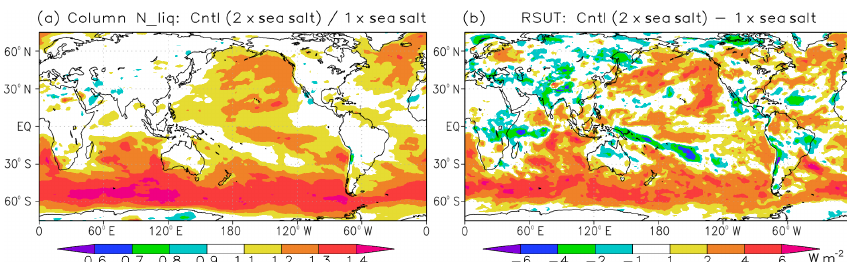
Figure 9. Impacts of doubled number concentration of sea salt CCN on (a) the column-integrated number concentration of cloud droplets (unitless) and (b) the TOA upward shortwave radiative flux (Wm − 2 ). The panels show the ratio (a) and the difference (b) between results for the control model (doubled number concentration of sea salt CCN) and those for an experiment using the original number concentration of sea salt CCN.